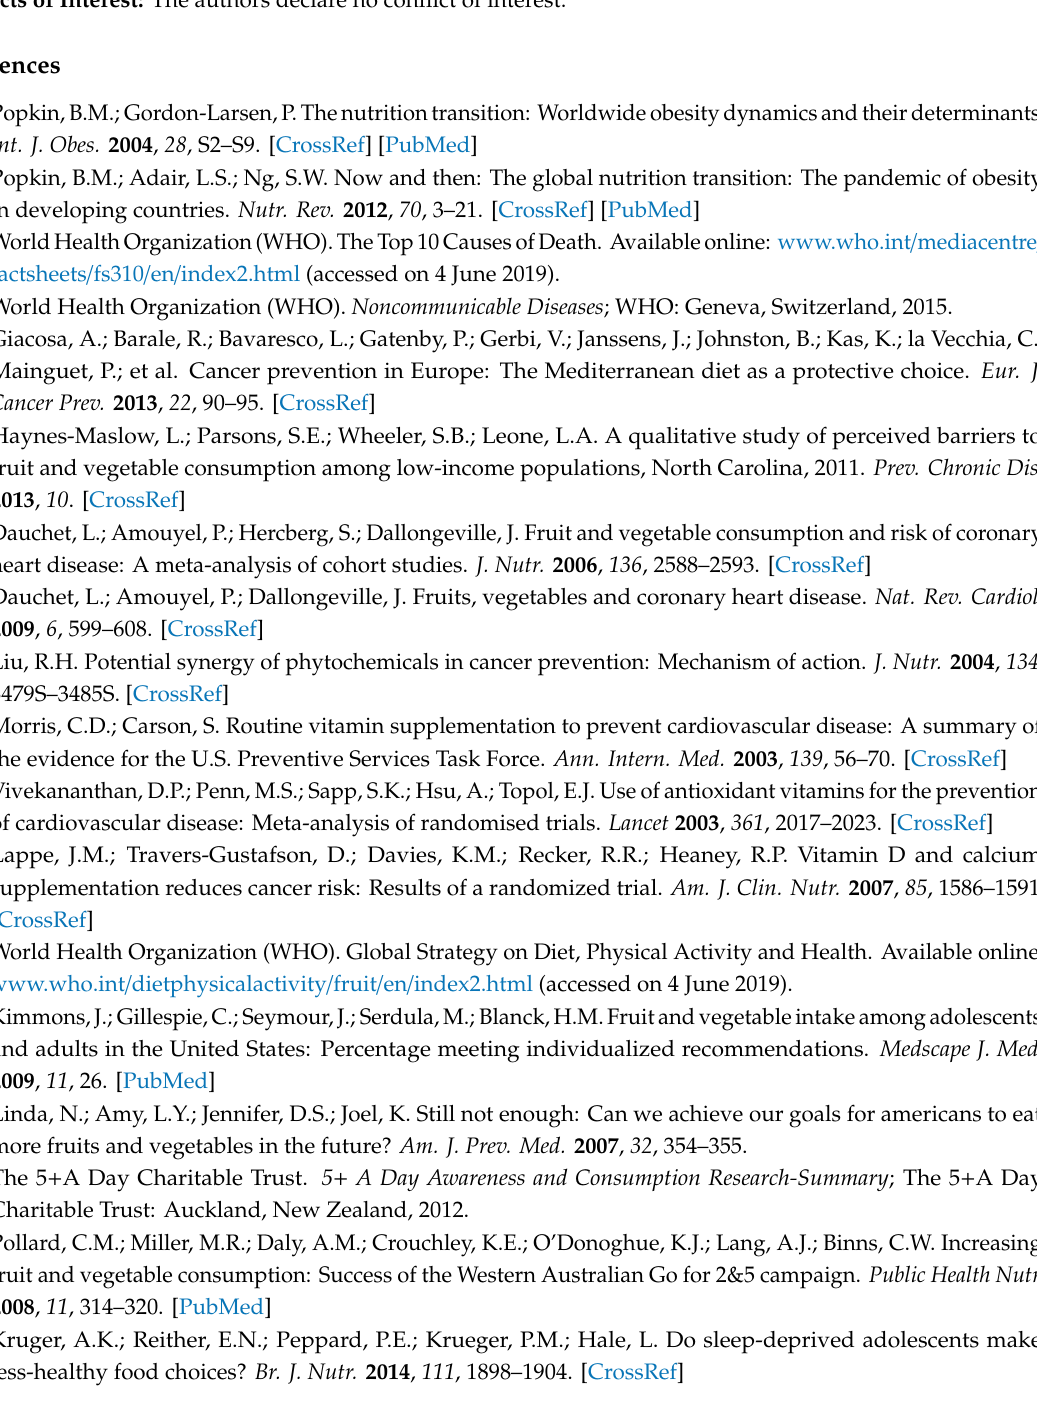
Table S1: Search strings and retrieved records. Numbers reported in bold characters are the final references included. Numbers reflect the records that were retrieved until June 22nd, 2018. Table S2: Articles used to estimate the e ff ect size of a single concentrate product on a specific clinical surrogate. Table S3: Composition of the concentrates administered in each study. The table reports the most frequently presented composition data in the papers included in the analysis. The empty cells indicate that the information was not reported in the